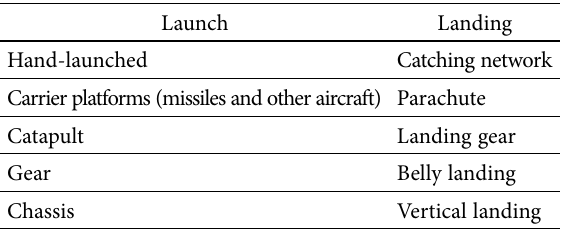
Table 1. Launch and landing methods